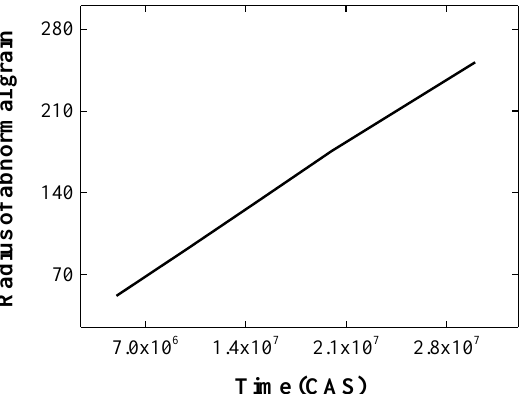
Figure 6. The linear relationship between the radius of the secondary grain and time.